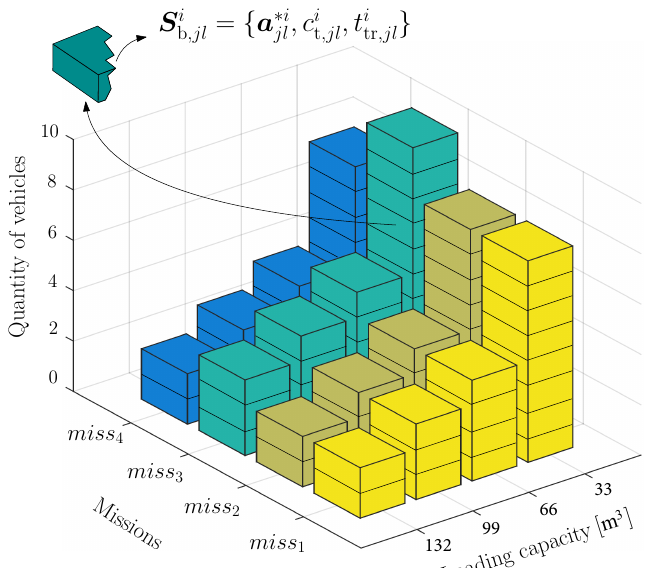
Figure 7. Look-up space S b